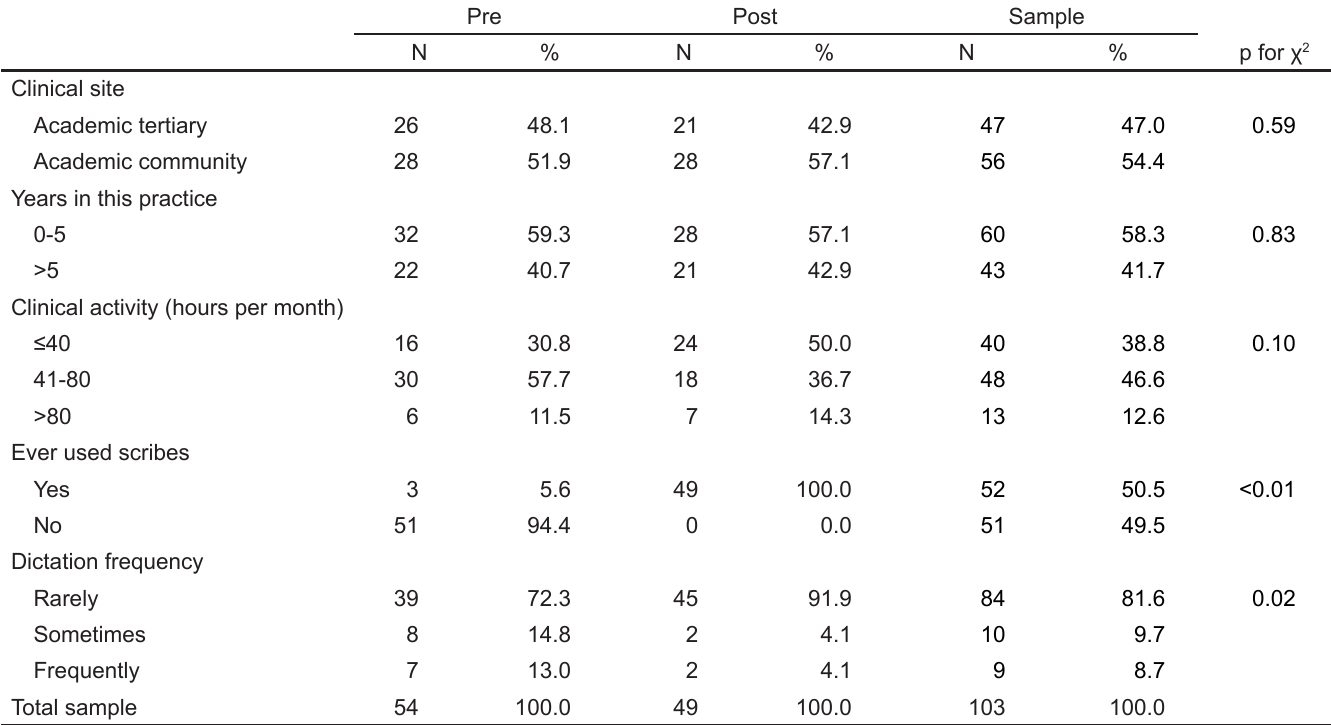
Table 1. Main characteristics of the study population, study sites, and pre-post differences with regard to the impact of the use of scribes on provider experience.